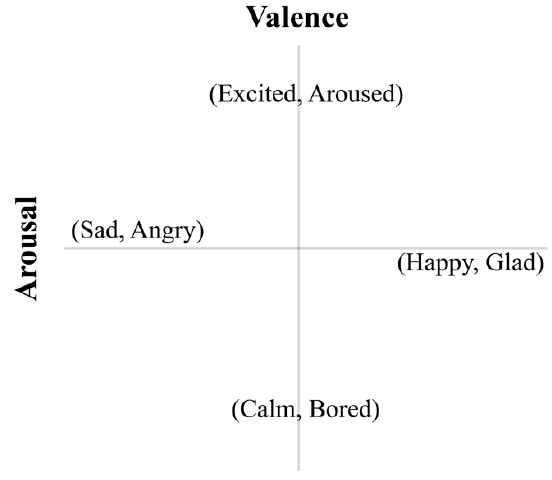
F igure 7. Classified emotional categories. Figure 7. Classified emotional